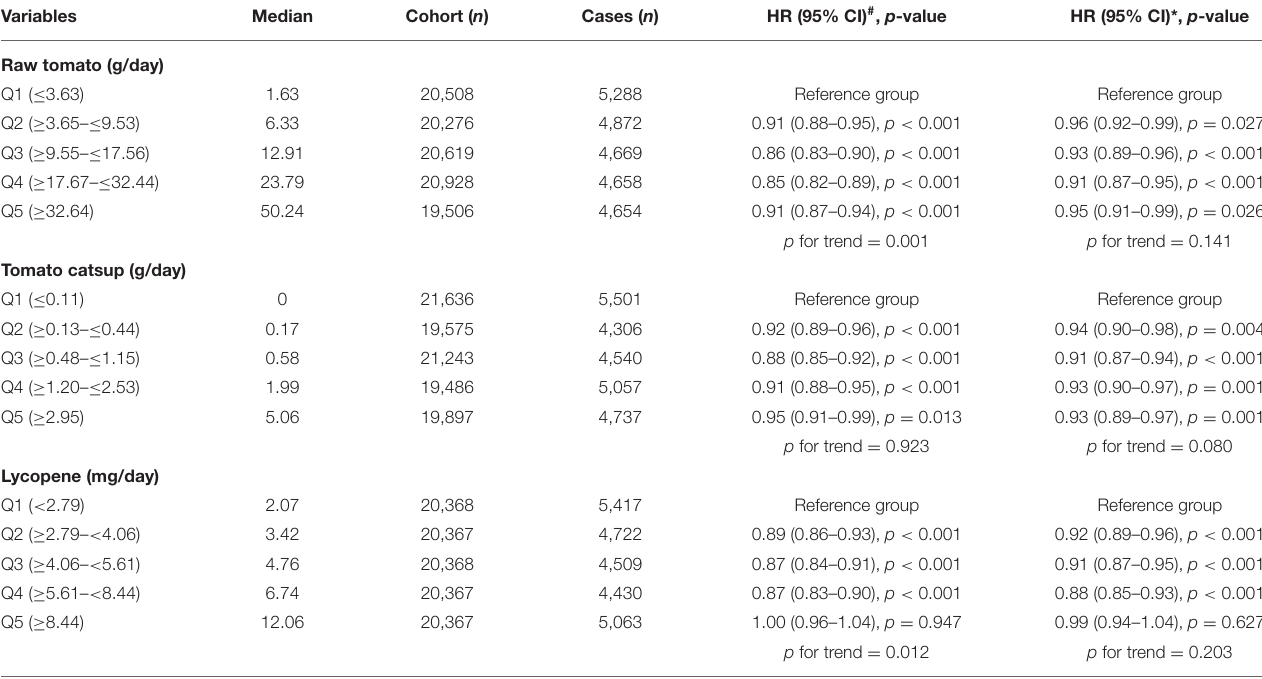
TABLE 2 | Associations between intake of raw tomato, tomato catsup or lycopene, and total mortality.